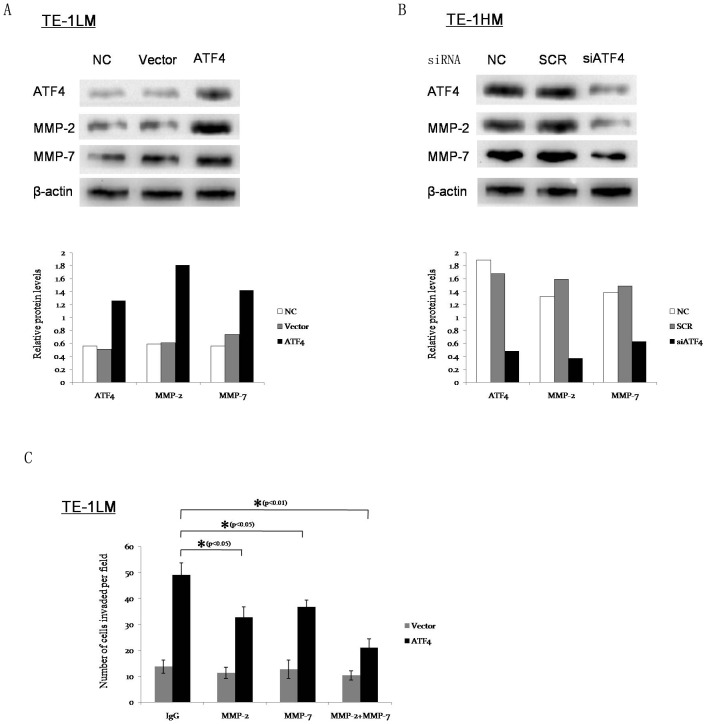
MMP-2 and MMP-7 are associated with and essential for ATF4-mediated tumor invasion and metastasis.(A) The protein levels of MMP-2 and MMP-7 in the TE-1LM-vector and TE-1LM-ATF4 cells were examined by Western blotting. β-actin was used as an internal control. The relative protein/β-actin ratio is shown (bottom). (B) The protein levels of MMP-2 and MMP-7 in the TE-1HM-SCR and TE-1HM-siATF4 cells were examined by Western blotting. The relative protein/β-actin ratio is shown (bottom). (C) The inhibition of MMP-2 and MMP-7 using neutralizing antibodies decreased ATF4-enhanced cell invasion. The TE-1LM-vector and TE-1LM-ATF4 cells were preincubated with the indicated antibody (2 µg/ml) for 24 h. Then, the invasive ability of the cells was examined using an in vitro invasion assay. During the assay, the cells were treated continuously with the indicated antibody. The data represent the means ± S.D. of three independent experiments.